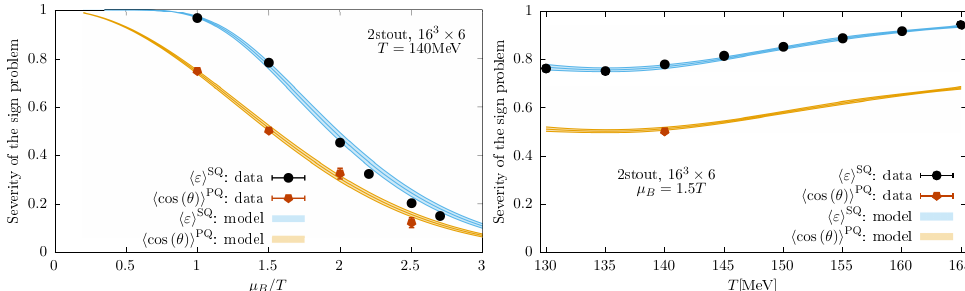
Figure 1: The strength of the sign problem on 2stout improved 16 3 × 6 staggered / T at T = 140 MeV (left) and as a function of T at lattices as a function of µ B µ / T = 1.5. A value close to 1 shows a mild sign problem, while a small value indi- B cates a severe sign problem. Data for sign reweighting (black) and phase reweighting (orange) are from simulations. Predictions of the Gaussian model (see text) are also